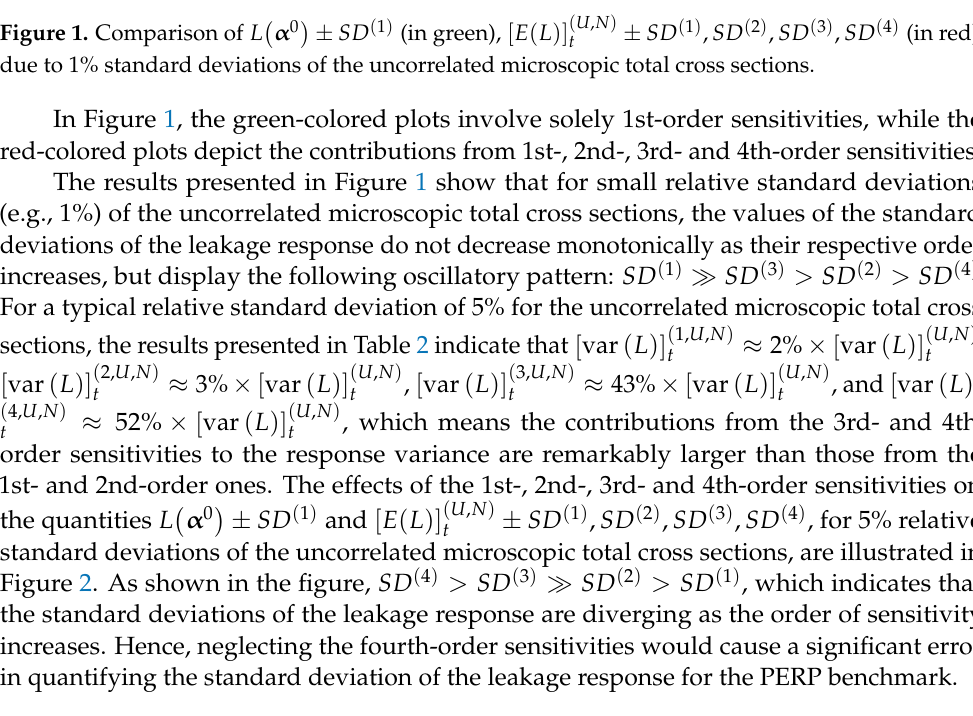
(cid:0) α 0 (cid:1) ± ( U , N ) ± SD ( 1 ) , SD ( 2 ) , SD ( 3 ) , SD ( 4 ) (in red), SD ( 1 ) (in green), [ E ( L )] t